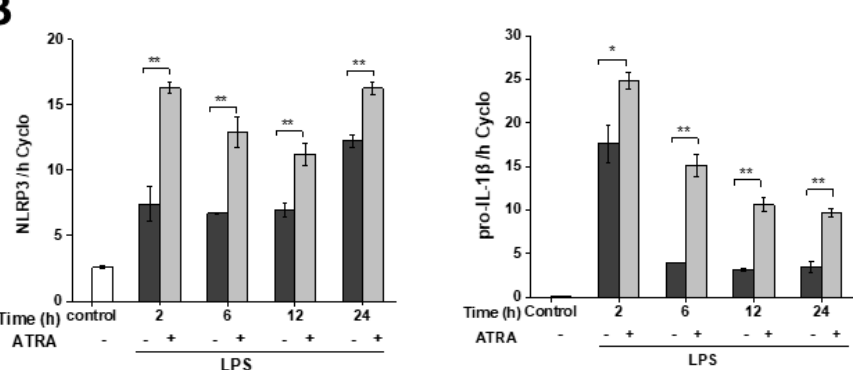
Figure 2. ATRA enhances LPS-induced pro-IL-1 β and NLRP3 expression in human M Φ s. M Φ s were pre-incubated with ATRA (1 µ M) where indicated prior to stimulation with LPS (100 ng / mL), then 5 mM ATP was applied for 45 min. ( A ) Representative immunoblot of NLRP3, pro-caspase-1, pro-IL-1 β , and ASC from the cell lysates; and released caspase-1 and IL-1 β in supernatant. Bar graphs represent the relative protein expression of pro-IL-1 β and NLRP3 determined by densitometry. β -actin was used as the internal control. ( B ) The relative gene expression of pro-IL-1 β and NLRP3 was measured by qPCR. The expression was normalized to the reference gene (human cyclophilin; Cyclo) expression. Data were obtained from at least four healthy donors. C, control (6 h mock-treated cells). All results are shown as means ± SEM. (* p < 0.05, ** p < 0.01, *** p < 0.001). + , − , presence or absence of indicated substance, respectively